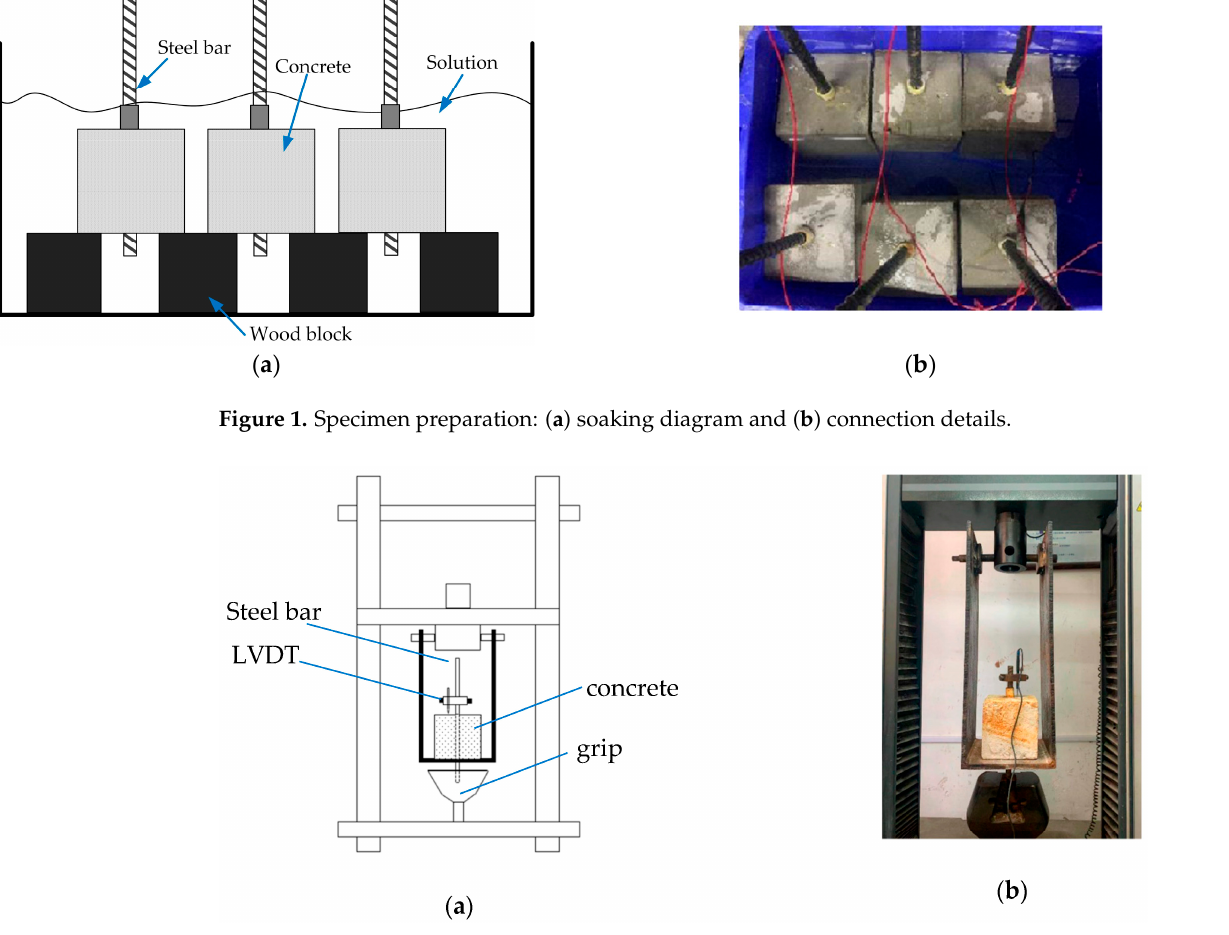
Figure 2. Bond test: ( a ) schematic test diagram and ( b ) actual setup.